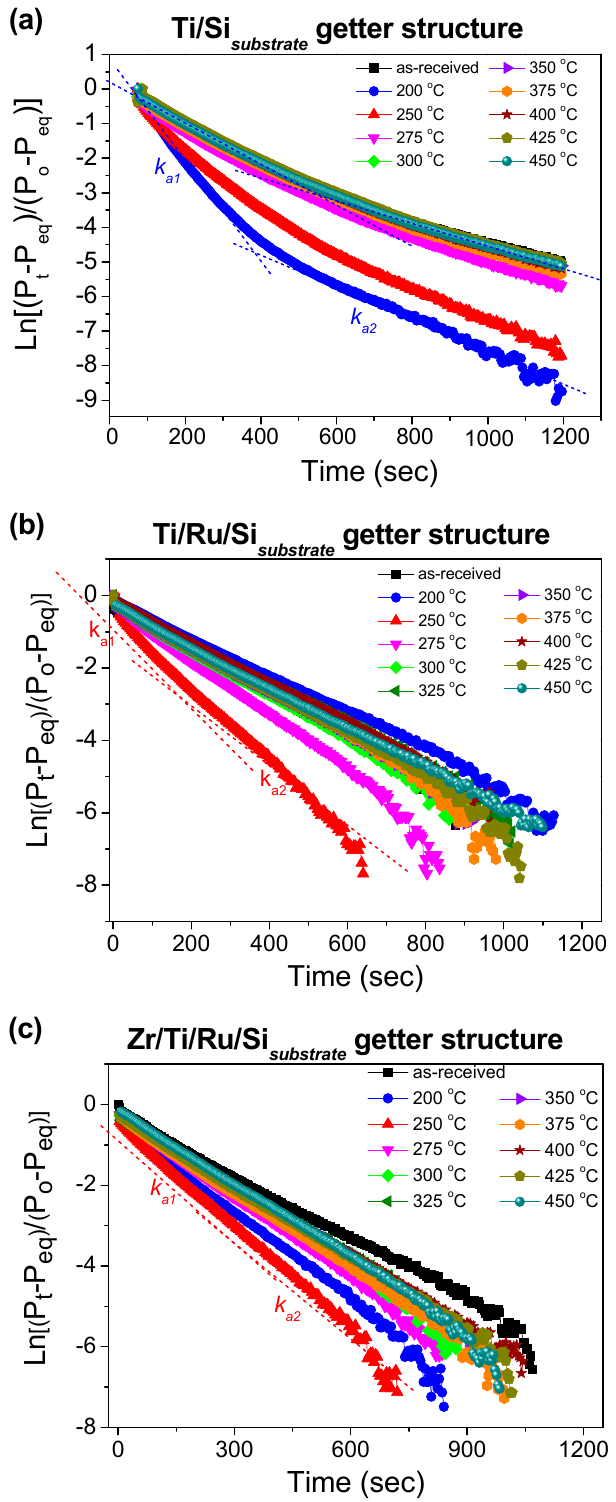
Figure 7. Kinetic curves for nitrogen sorption after different activation temperatures; ( a ) single layer Ti/Si NEG; ( b ) multilayer Ti/Ru/Si NEG and ( c ) multilayer Zr/Ti/Ru/Si NEG.